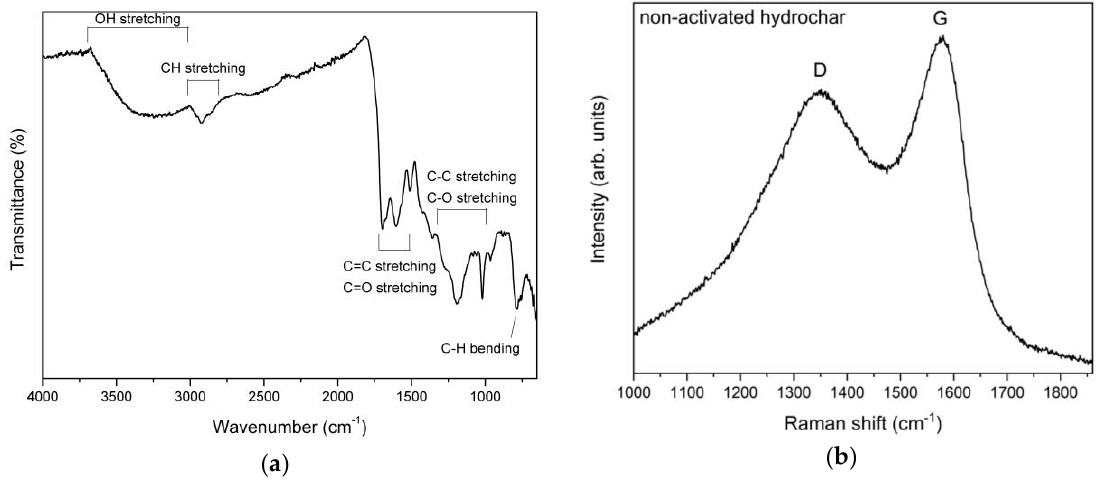
Figure 5. Spectroscopic characterization of hydrochar microspheres: ( a ) FT-IR spectrum; ( b ) Raman spectrum, with I D / I G = 0.83.